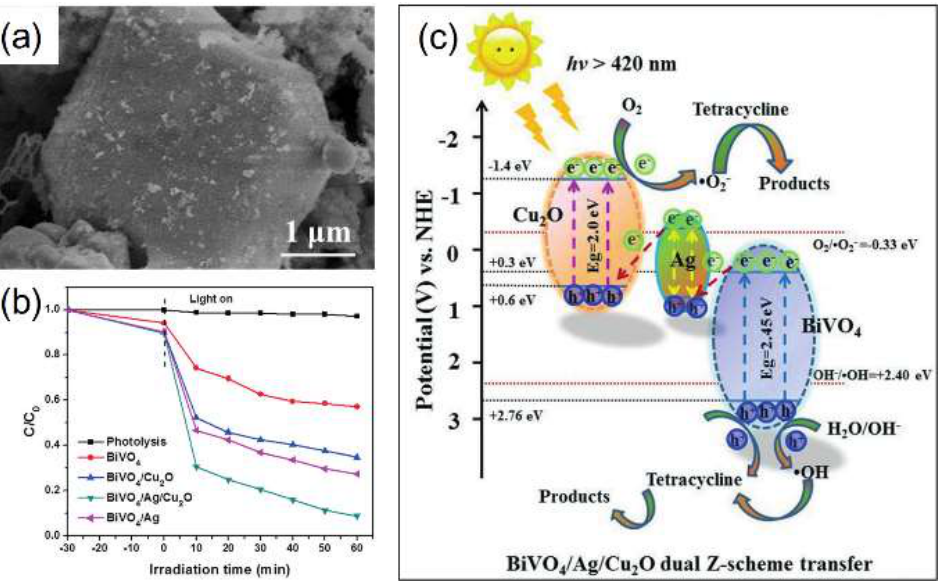
Figure 7. ( a ) Morphology characterization of BiVO 4 /Ag/Cu 2 O composites. ( b ) The photocatalytic performance of different photocatalysts. ( c ) Possible reaction mechanism in the BiVO 4 /Ag/Cu 2 O nanocomposite-based reaction systems. Copyright 2017 Royal Society of Chemistry.